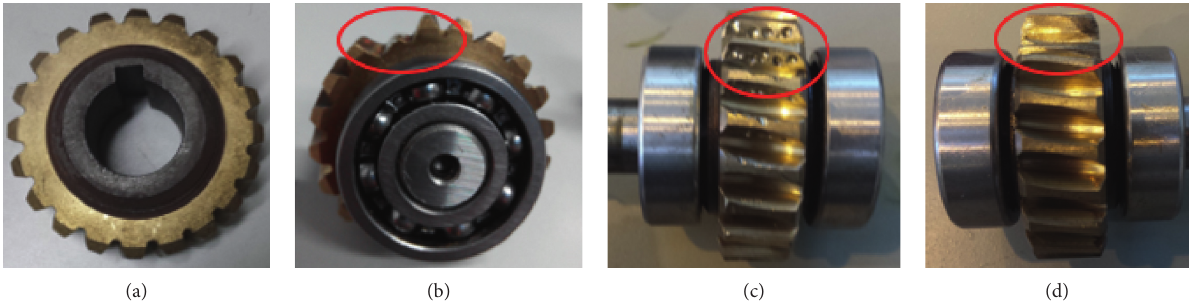
Figure 9: Normal worm gear and worm gears with artificial faults [25]: (a) normal; (b) broken; (c) pitting; (d) spalling. Load free Load 6N.m